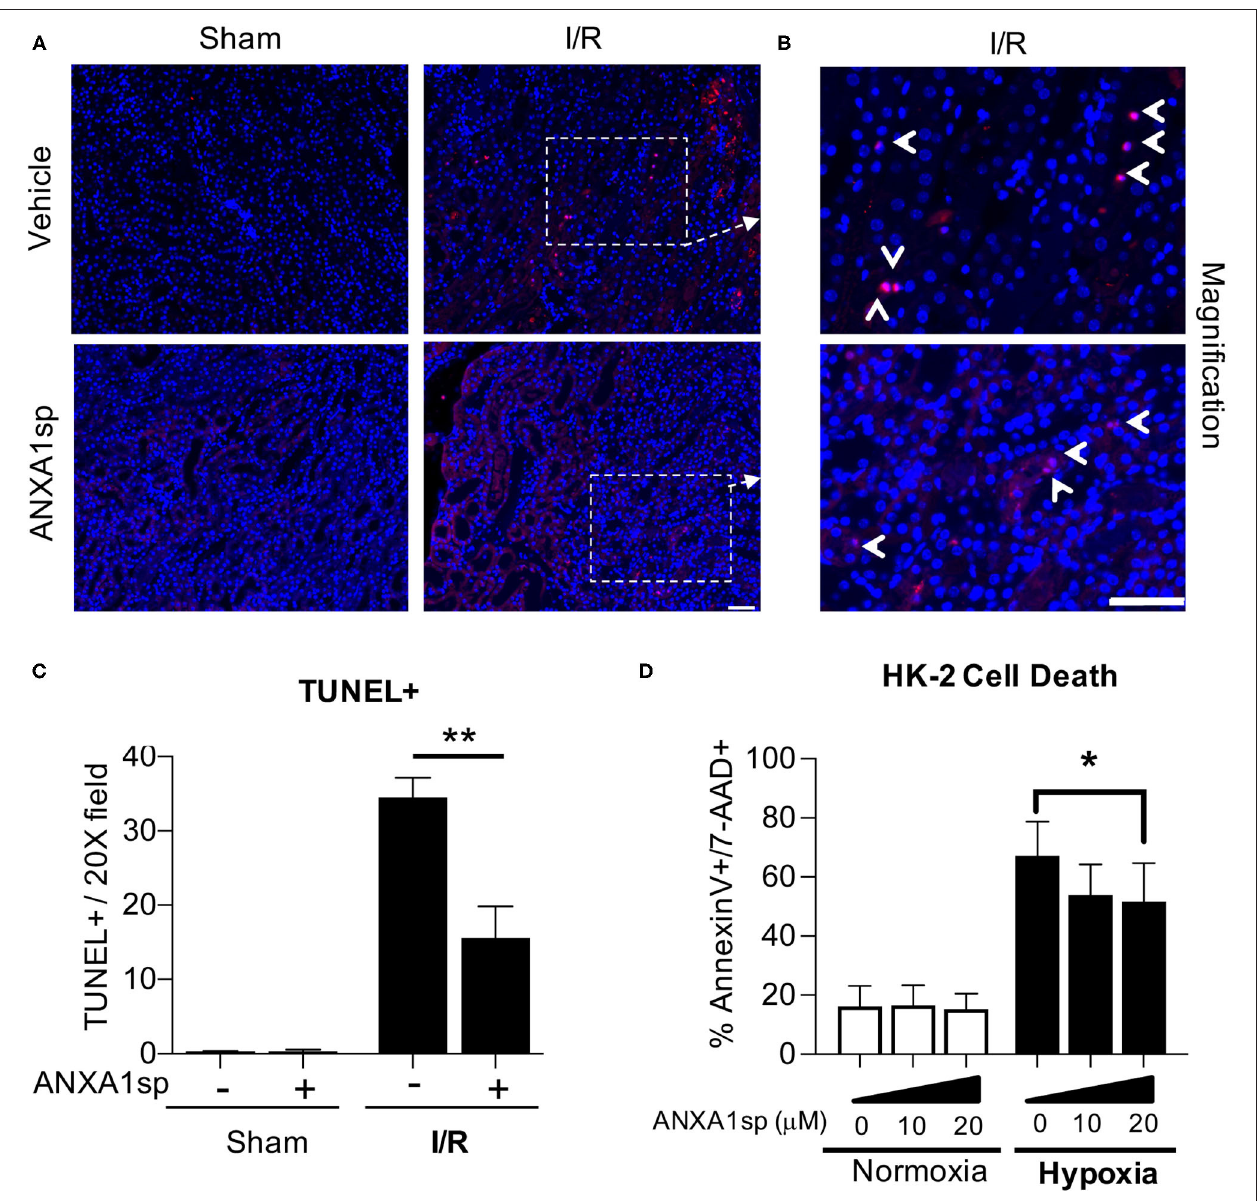
FIGURE 2 | ANXA1sp treatment prevents kidney tubular cell death. Mice were treated with either Vehicle or ANXA1sp 1h prior to ischemia, subjected to 33 minutes of unilateral ischemia and contralateral nephrectomy and then re-injected with Vehicle or ANXA1sp 1h after reperfusion. (A ) Kidney tissues were harvested at 24h after reperfusion. Representative terminal deoxynucleotidyl transferase dUTP nick end labeling (TUNEL)-stained kidney sections demonstrating increased apoptosis in Vehicle, I/R group at Day 1 after ischemia. Scale bar shows 25 µ m. (B) Increased magnification of boxes in (A) to demonstrate increased evidence of apoptosis in Vehicle, I/R mice (arrowhead: TUNEL-positive nuclei) compared to ANXA1sp-treated mice. Scale bar shows 25 µ m. (C) Quantification of TUNEL positive nuclei from (A) . Graph displays mean + /- SEM of % TUNEL positive nuclei from five fields/section from each mouse ( n = 3 for Sham and I/R groups) with significance determined by two-way ANOVA with Sidak post-test (** p < 0.01). ( D ) The immortalized human kidney cell line, HK-2, was grown to confluence in monolayers. Cells were pretreated with Vehicle or ANXA1sp at increasing concentrations and then subjected to 16h of oxygen-glucose deprivation (hypoxia) in an anaerobic chamber. ANXA1sp prevented hypoxic cell death ( n = 5–6/condition). Graphs display mean + /- SEM with significance determined by two-way ANOVA with Sidak post-test (* p < 0.05).